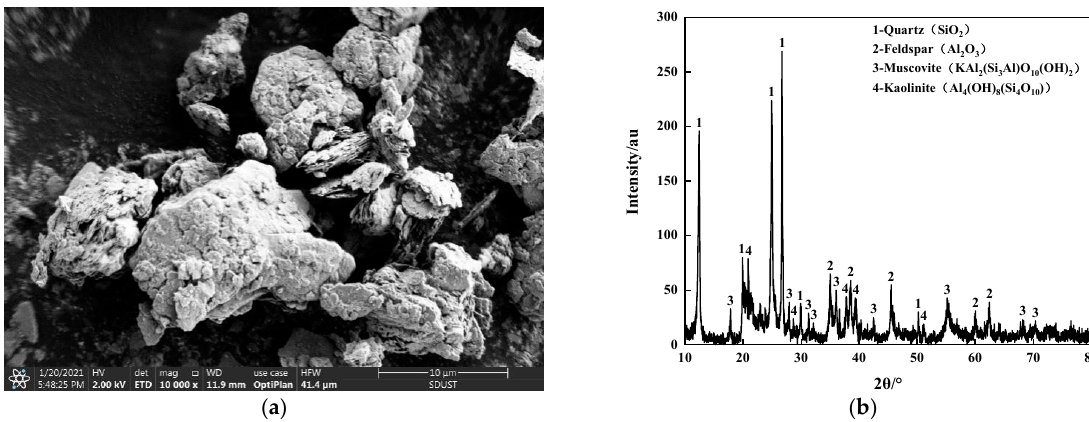
Figure 2. Microstructure analysis of kaolin. ( a ) SEM of kaolin; ( b ) XRD pattern of kaolin. The crystal phase of the kaolin admixture was analyzed using XRD, as shown in Fig- ure 2b [22]. The XRD patterns show multiple dispersion peaks of quartz, feldspar, musco- vite, and kaolinite, among which quartz and feldspar are mainly composed of SiO 2 and Al 2 O 3 , respectively. The kaolin admixture is rich in active SiO 2 and Al 2 O 3 , which can re- place a part of the cement for pozzolanic reaction and improve the internal bonding of CGFB samples. 2.2. Sample Preparation In this test, CGFB samples were prepared using cement, fly ash, and gangue in the ratio of 1:4:6; the solid mass fraction was 78%; no additions were added, and the amounts of kaolin replacing cement were 0, 10, 20, 30, 40, and 50%. During the preparation of CGFB samples, an NJ-160 agitator was used for stirring for approximately 8 min. After the slurry was evenly mixed, it was poured into a Φ 50 mm × 100 mm mould. The bubbles in the samples were removed by manual vibration and tamping. CGFB samples were removed from moulds after 24 h and cured for 28 days in a curing box at a temperature of 25 °C and relative humidity of 80%. Before the test, the two ends of the samples were smoothed with a grinding machine: the flatness tolerance of the end face was less than 0.05 mm, and unevenness was less than 0.002 mm [23]. Evident cracks on the surface of the CGFB sam- ples were removed. A total of 18 samples, as shown in Figure 3, were prepared for this test. Based on the amounts of cement replaced with kaolin, they were divided into six groups: A, B, C, D, E, and F, corresponding to cement replacement of 0, 10, 20, 30, 40, and 50% chemically pure (CP), respectively, and each group contained three samples. Figure 3. CGFB samples.